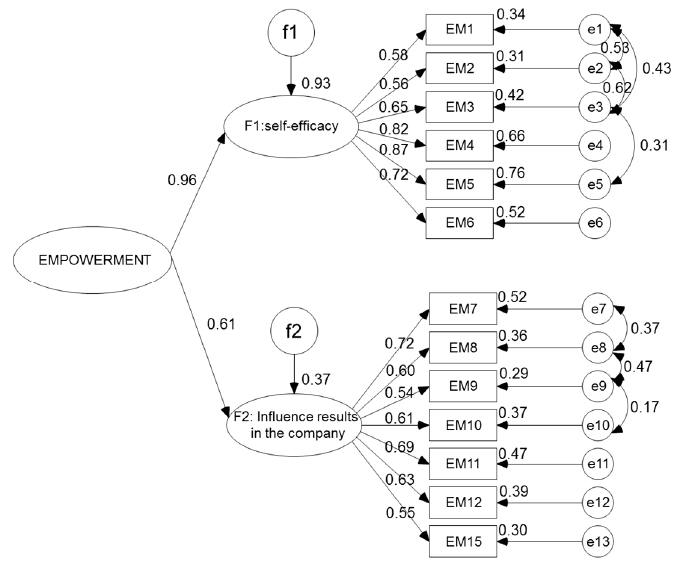
Figure 2. Model 4, 1st order model.